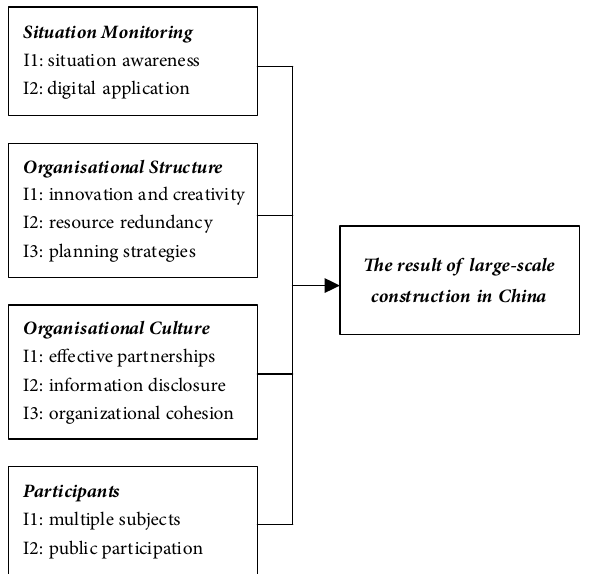
Figure 2. Research model of organisational resilience factors of construction